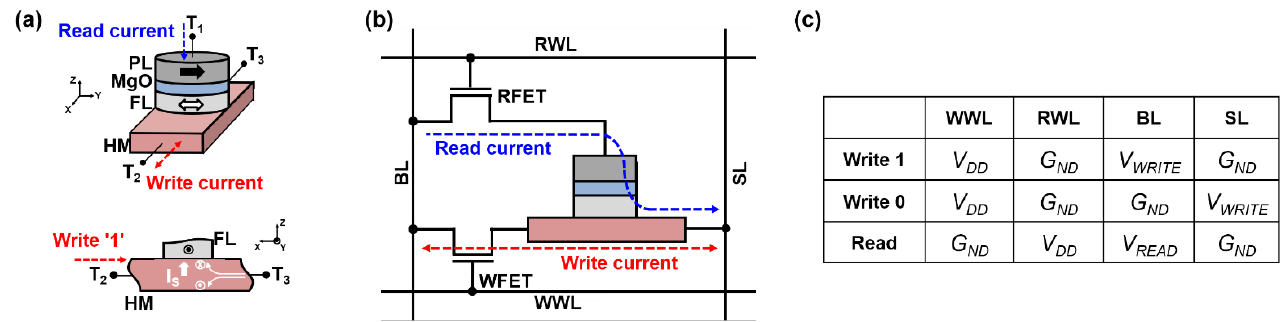
Figure 2. ( a ) Spin-orbit torque (SOT) device structure; ( b ) high-density spin-orbit torque magnetic random-access memory (SOT-MRAM) bit-cell; ( c ) biasing condition for write and read.